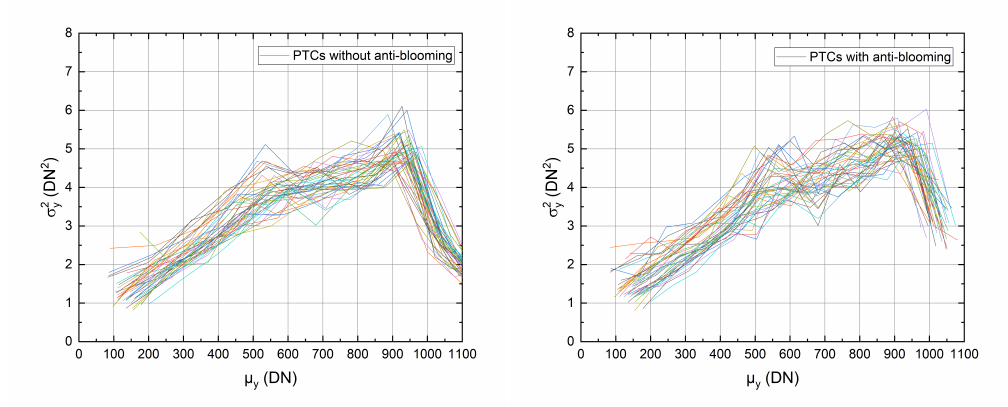
Figure 8. PTCs without implemented anti-blooming clocking ( left ) and PTCs with implemented anti-blooming clocking ( right ) for 64 TDI